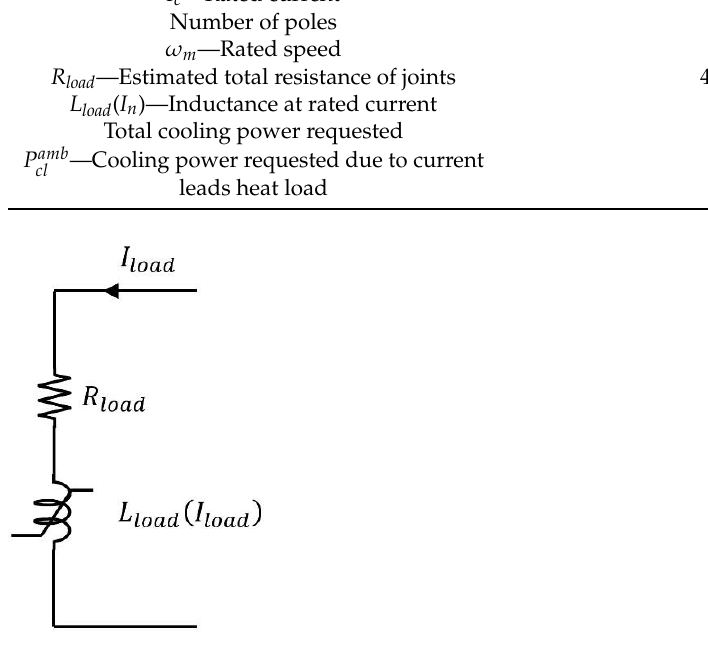
Figure 2. Equivalent circuit scheme of the HTS field